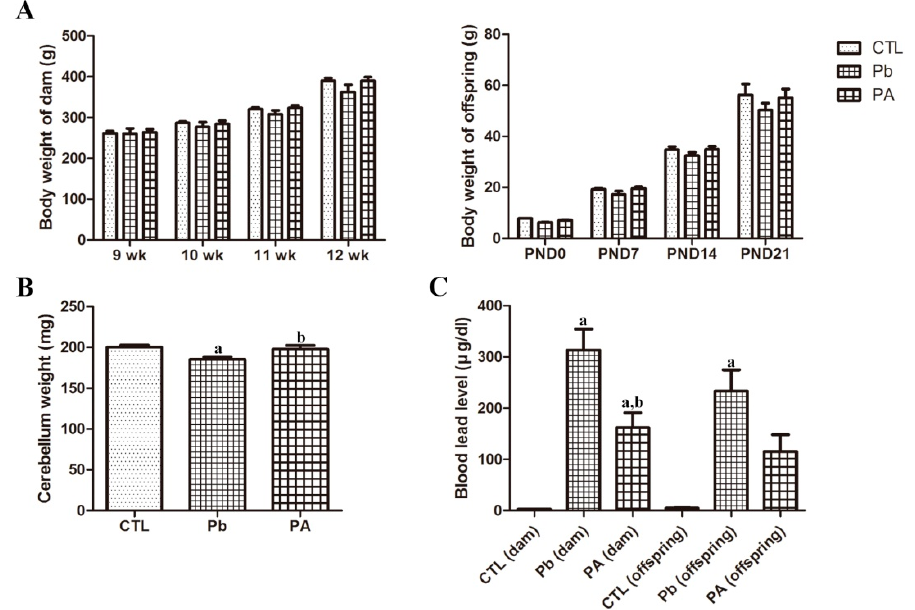
Figure 1. Body weights of dams ( n = 3 per group) during gestation and offspring ( n = 12 per group) on postnatal days (PND) 0, 7, 14, and 21 in control (CTL), lead (Pb), and Pb+ ascorbic acid (PA) groups ( A ). Cerebellar weights of offspring on PND21 ( B ). Blood Pb levels in the dams and offspring on day 21 after delivery ( C ) ( a p < 0.05, indicating a significant difference compared with the control group, b p < 0.05, indicating a significant difference compared with the Pb group). The bars indicate means ± standard errors of